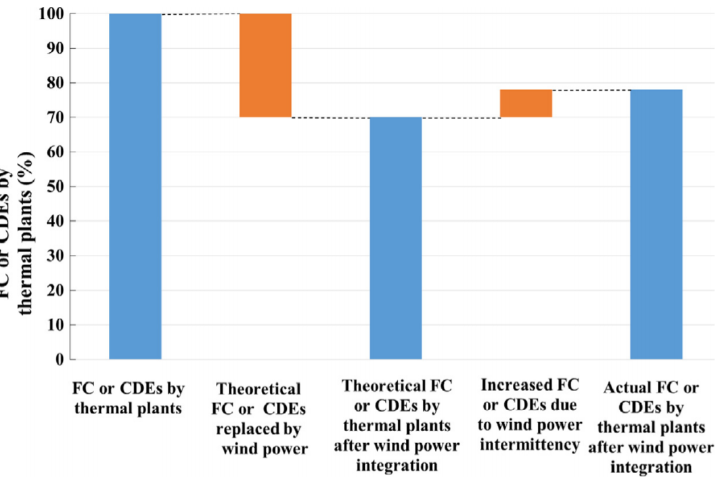
Figure 3. Schematic of the expected and actual reduction in fuel consumption (FC) or CO 2 emissions (CDEs) with penetration of an intermittent RES, reproduced with permission from